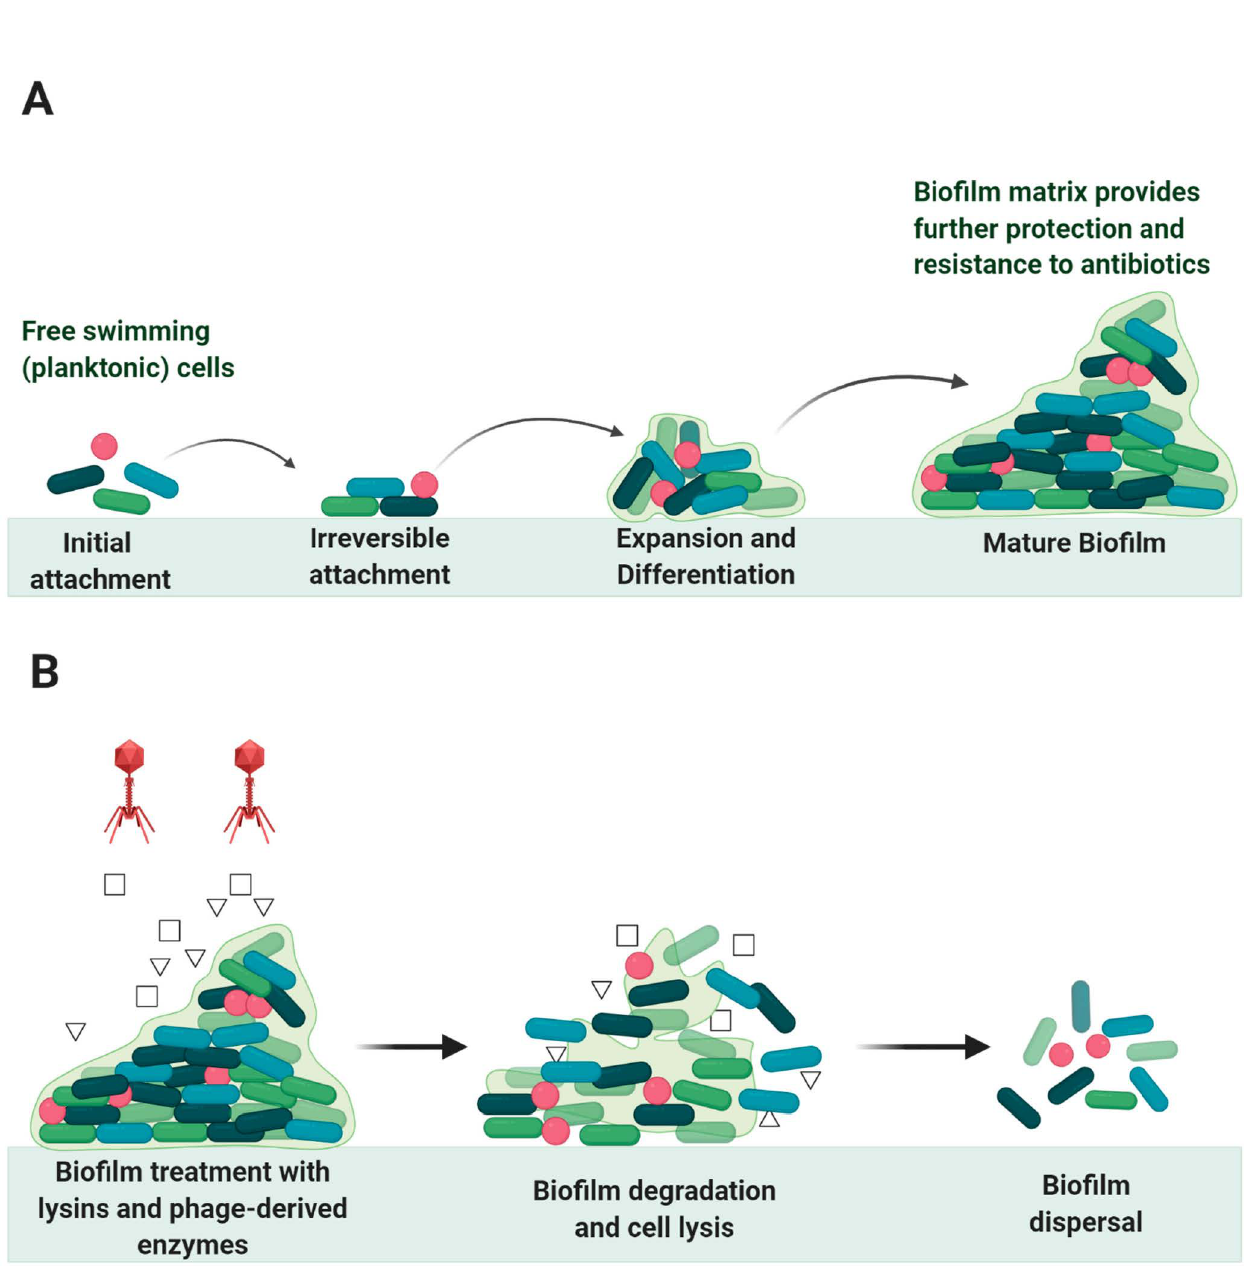
Figure 7. Biofilm growth stages and degradation: ( A ) the stages of bacterial biofilm formation from the initial attachment to mature biofilm formation, ( B ) the process of biofilm dispersal using phage endolysins and phage-derived enzymes as agents of biofilm degradation and bacterial cell